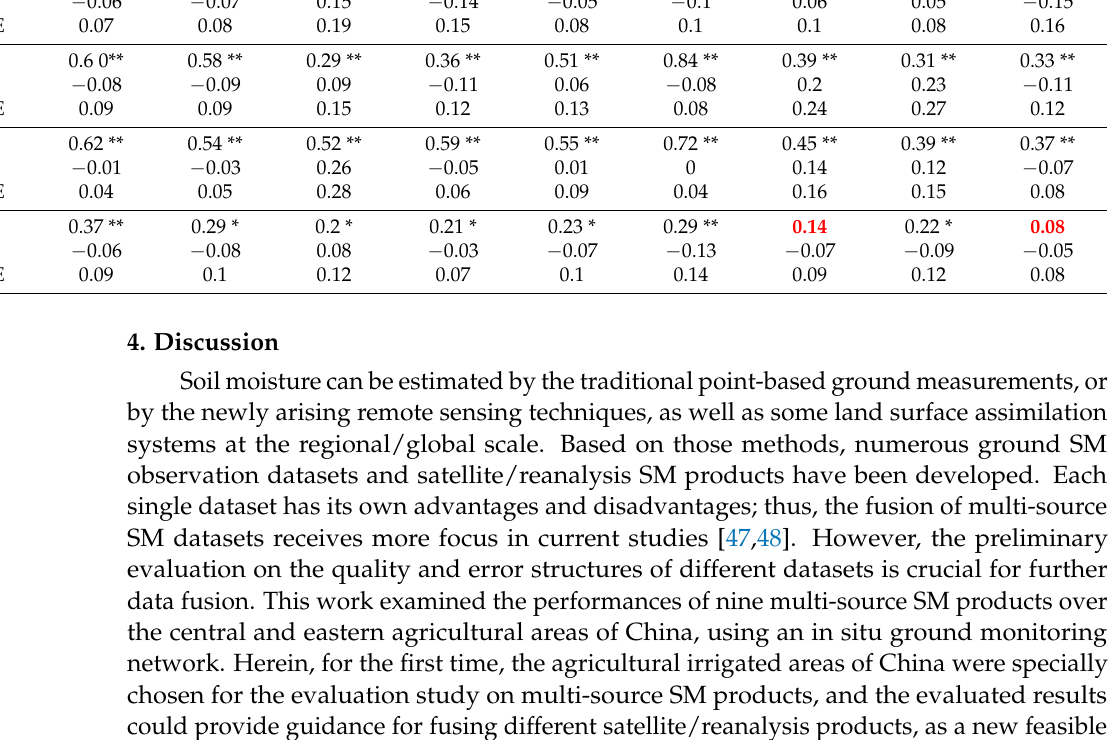
Table 2. Performance evaluation of multi-source SM products in four different wet–dry areas. (Herein, ** indicates significant correlation at p < 0.001, * indicates significant correlation at p < 0.05 and red number indicates non-significant correlation.) Wet–Dry